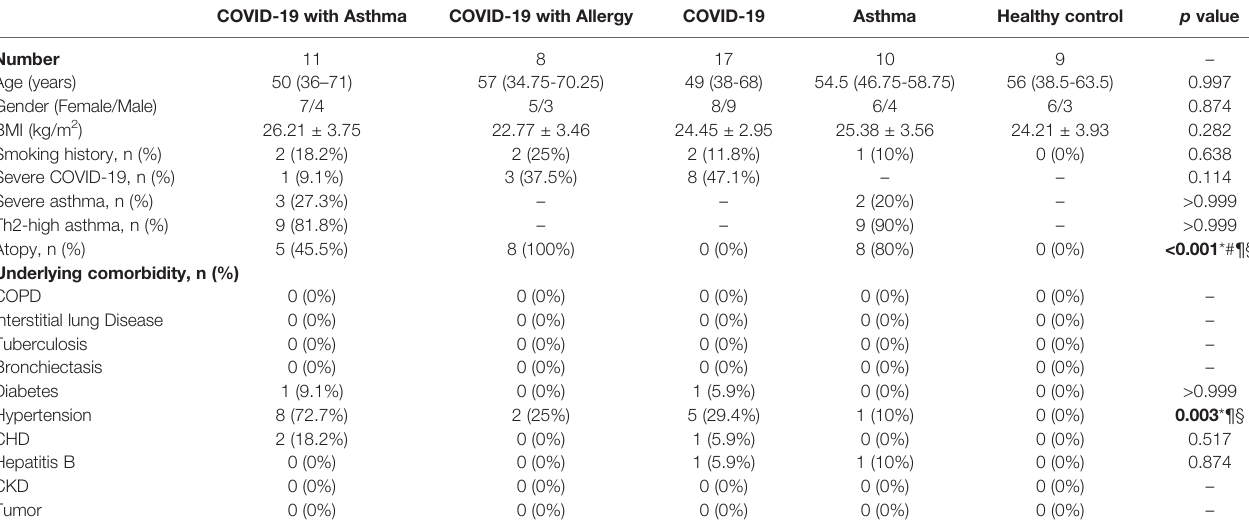
TABLE 1 | Demographic and baseline clinical characteristics of subjects. COVID-19 with